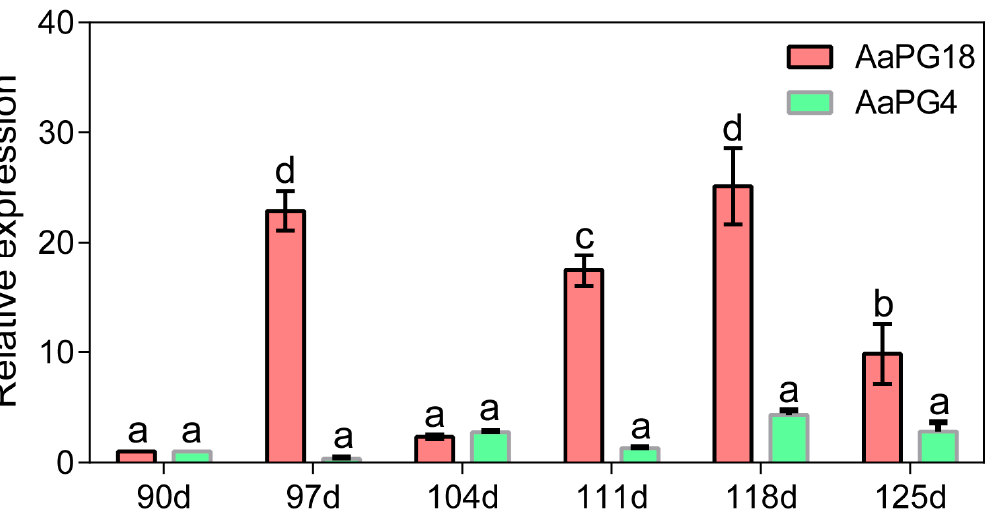
Figure 3. The expression levels of AaPG4 and AaPG18 in fresh fruit flesh at six preharvest stages. Kiwifruit β‐ actin was selected as an internal control gene during qPCR. Values are presented as means ± SD for three replicates. The statistical significance of mean values is indicted by different letters.